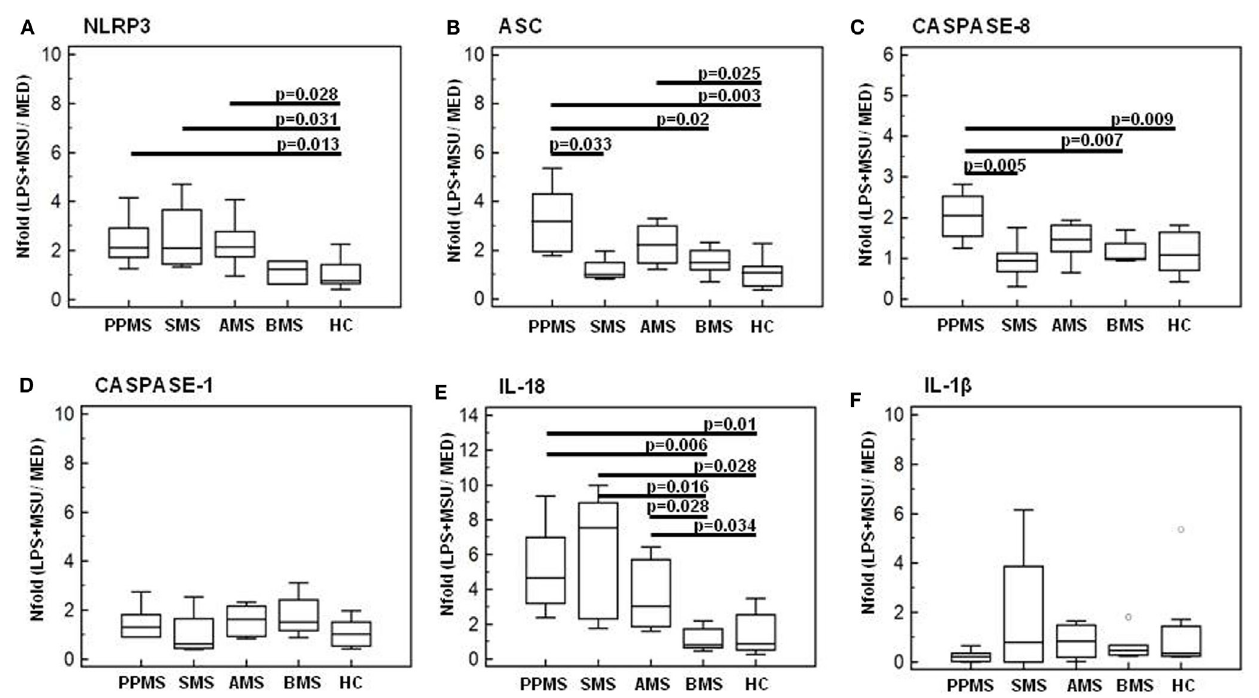
FigUre 6 | Genes of inflammasome proteins in lipopolysaccharide (LPS)-primed and monosodium urate crystals (MSU)-stimulated PBMCs. mRNA expression by real-time PCR. Single real-time PCR results obtained in LPS-primed and MSU-stimulated immune cells of primary progressive (PP, n = 11), acute relapsing-remitting (A, n = 10), stable relapsing-remitting (S, n = 10), or benign (B, n = 10) Multiple sclerosis (MS) patients and healthy controls (HC, n = 10). Nod-like receptor protein 3 (NLRP3) (a) , ASC (B) , caspase-8 (c) , caspase-1 (D) , IL-18 (e) , and IL-1 β (F) mRNA levels are shown. The results are indicated as fold-change expression from the unstimulated samples. Summary results are shown in the bar graphs. The boxes stretch from the 25 to the 75 percentile; the line across the boxes indicates the median values; the lines stretching from the boxes indicate extreme values. Statistical significance is